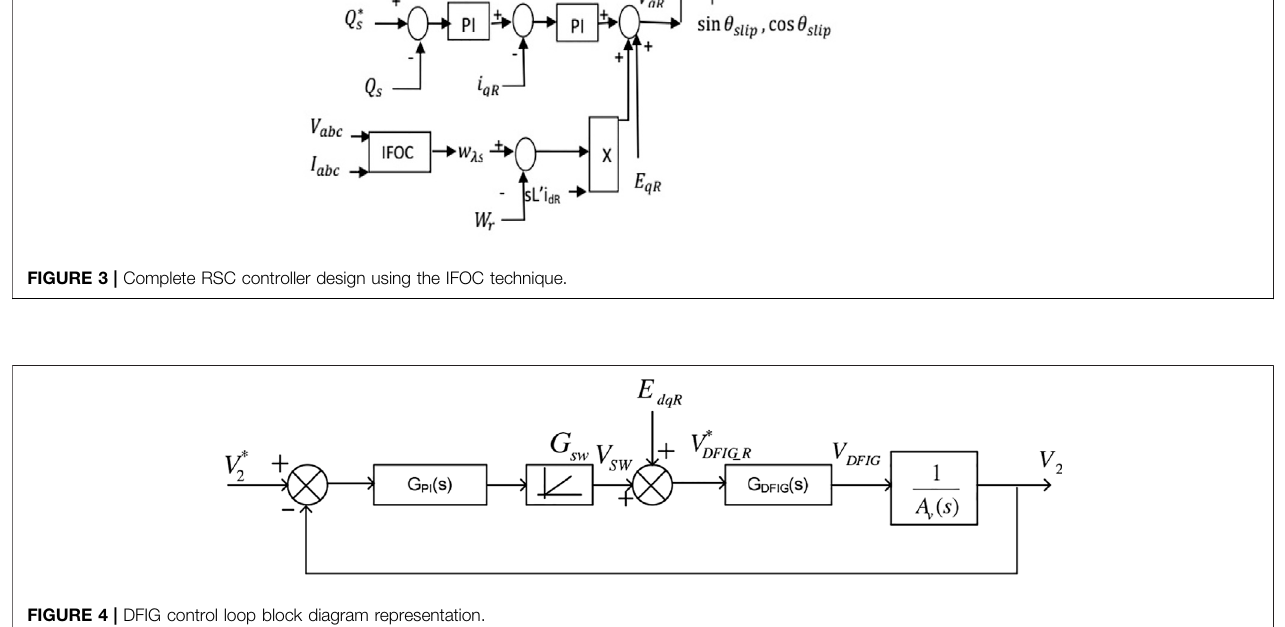
FIGURE 4 | DFIG control loop block diagram representation.